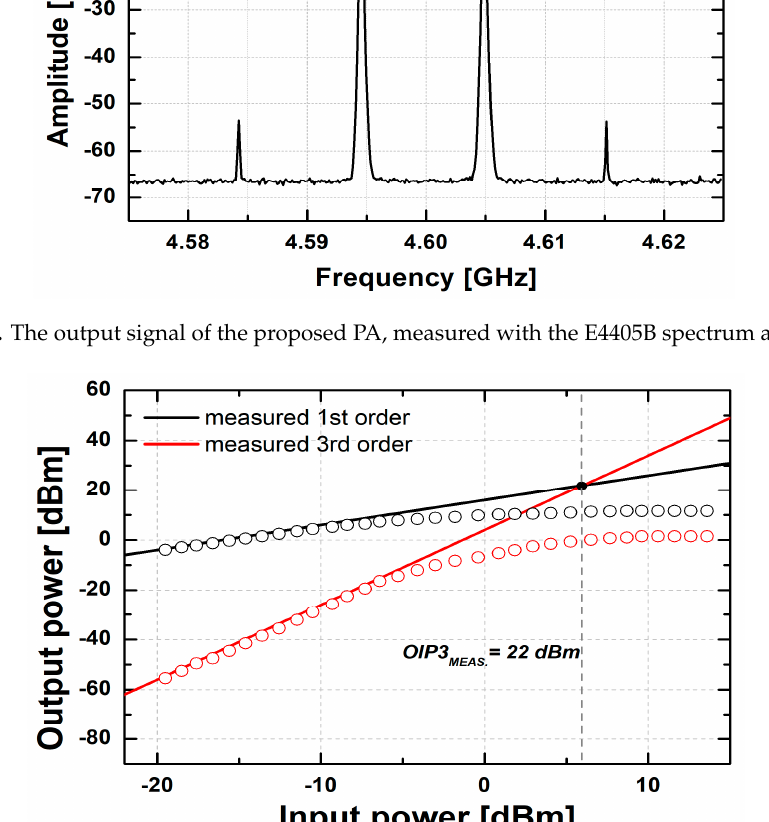
Figure 9. The measured output-referred third-order intercept point (OIP3) of the proposed two-stage PA.